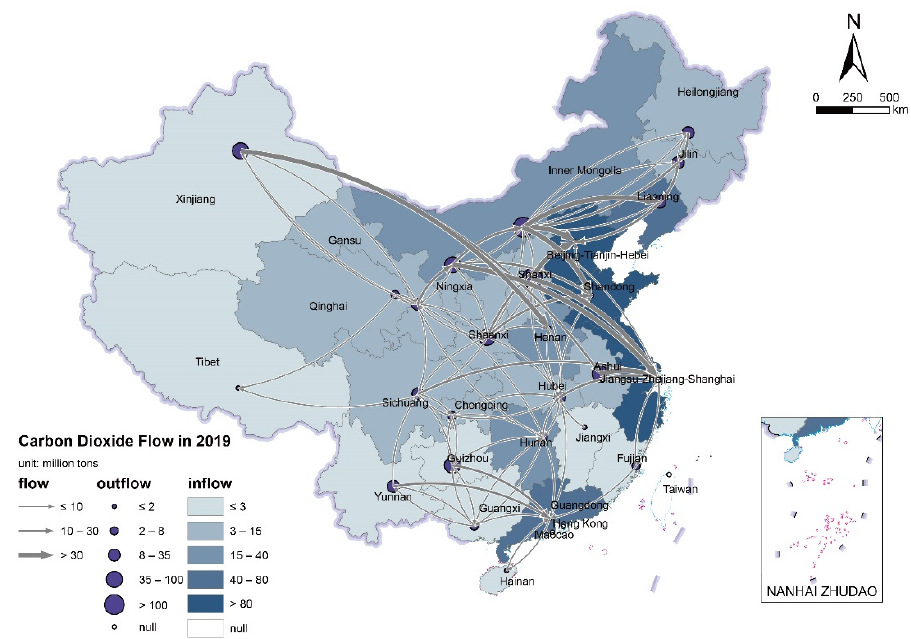
Figure 6. Spatial pattern of inter-provincial CO 2 flow from electricity, 2019 .